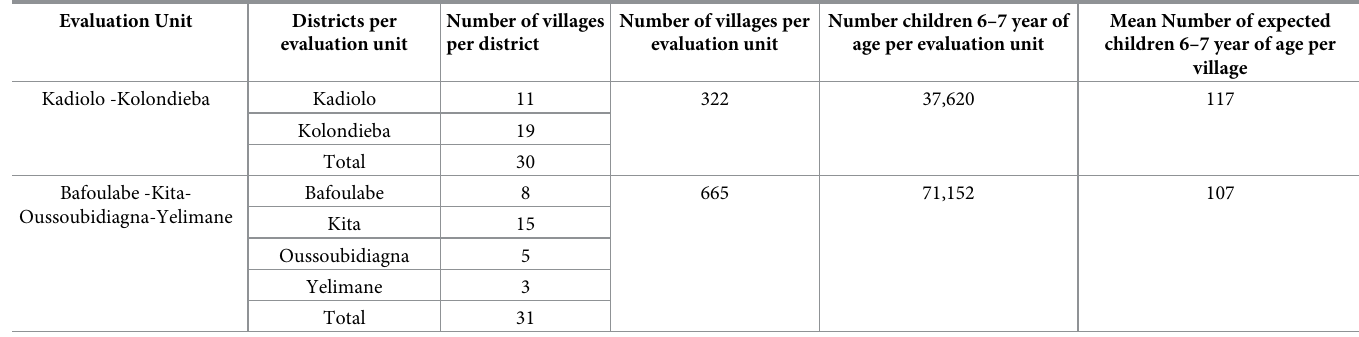
Table 2. Study area description per evaluation unit and details on number of villages and mean number of expected children. Evaluation